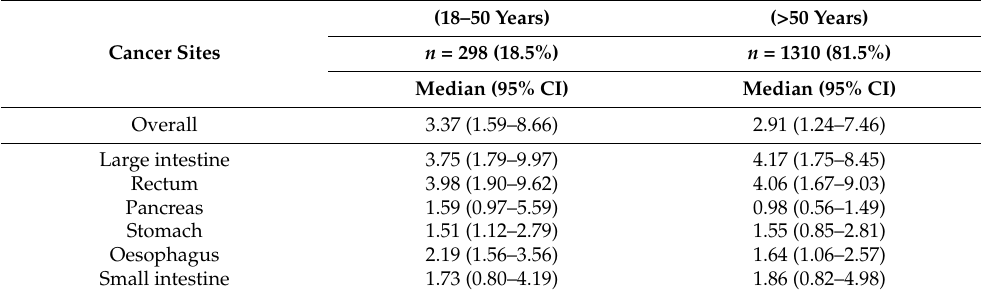
Table 3. Median survival times (years) for primary sites of cancer between two age groups ( n = 1608).